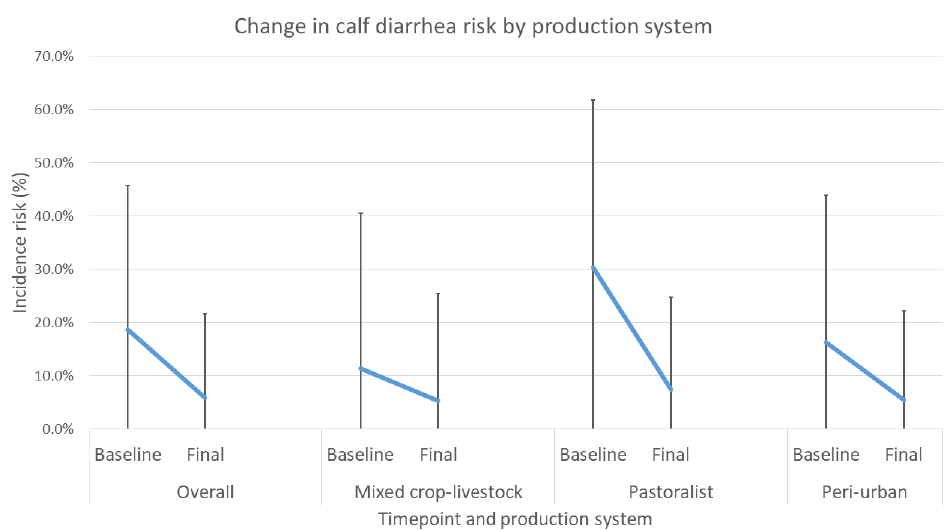
Figure 7. Change in average diarrhea risk in calves between baseline and final overall evaluation and for each production system with standard deviation bars. Table 15. Calf diarrhea risk model predictions.